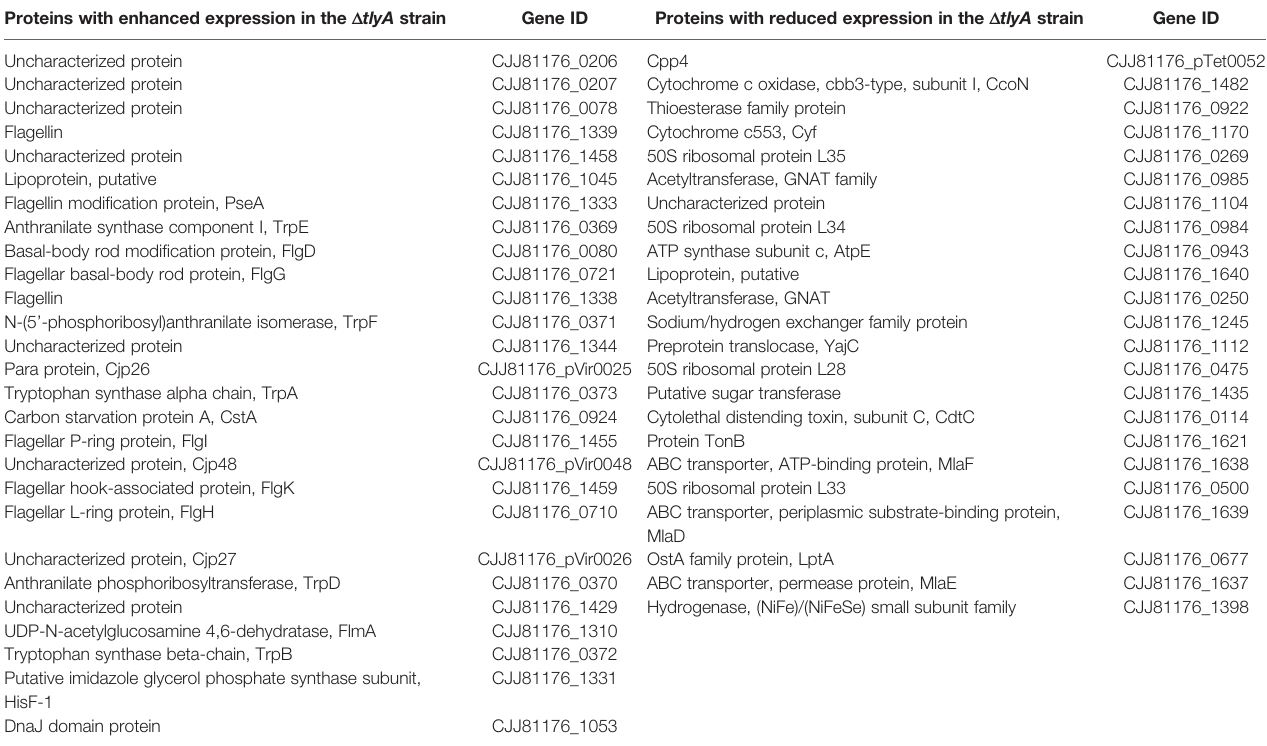
TABLE 2 | Signi fi cant changes in the proteome of the C. jejuni D tlyA strain compared with the wild-type strain. Proteins with enhanced expression in the D tlyA strain Gene ID Proteins with reduced expression in the D tlyA strain Gene